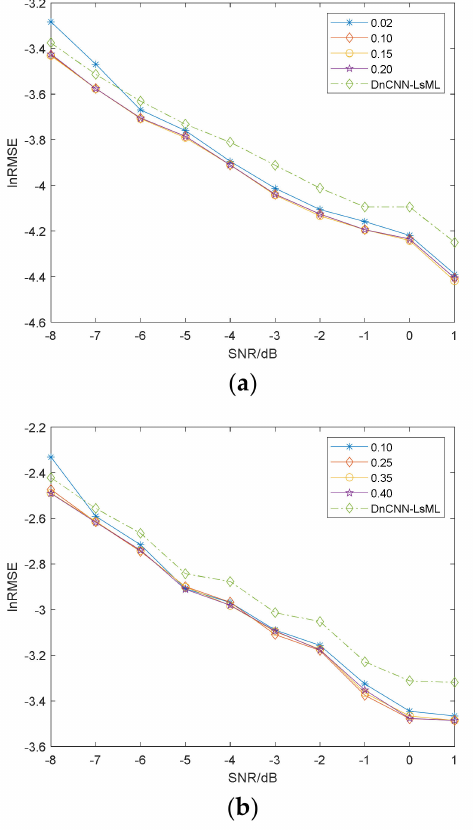
Figure 10. lnRMSE of initial frequency and chirp rate estimation versus σ . ( a ) is lnRMSE of initial frequency, ( b ) is lnRMSE of chirp